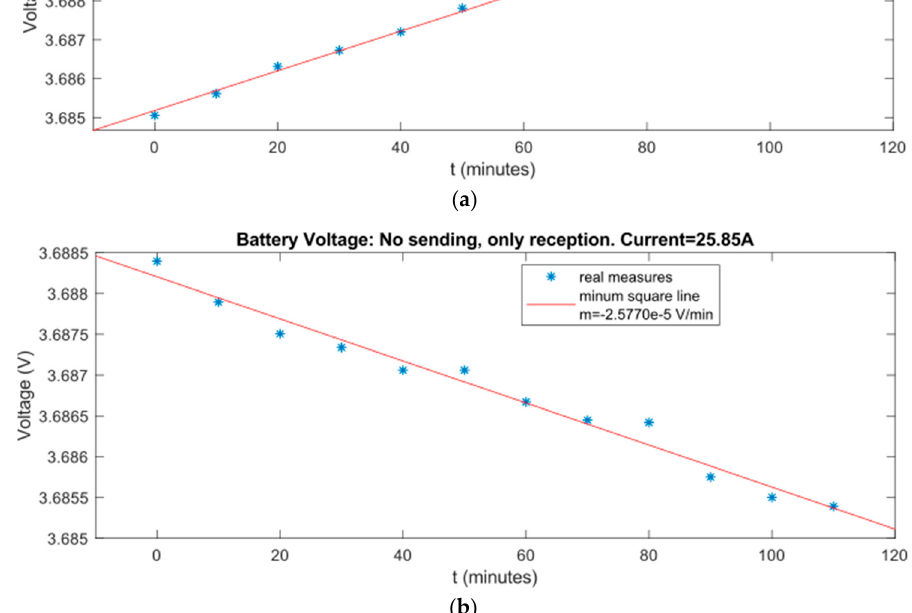
Table 4. Node consumptions while harvesting energy (current of 25 A through coupled power line).